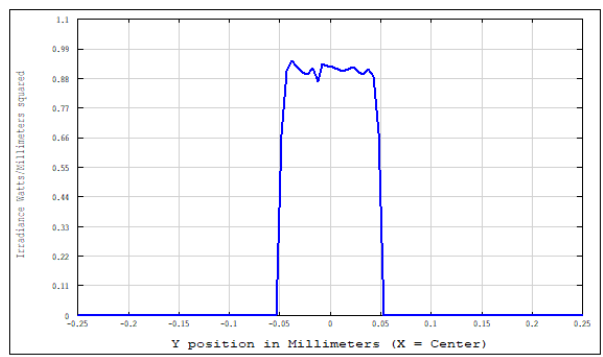
Figure 8. Light-field-intensity distribution in the Y-direction.